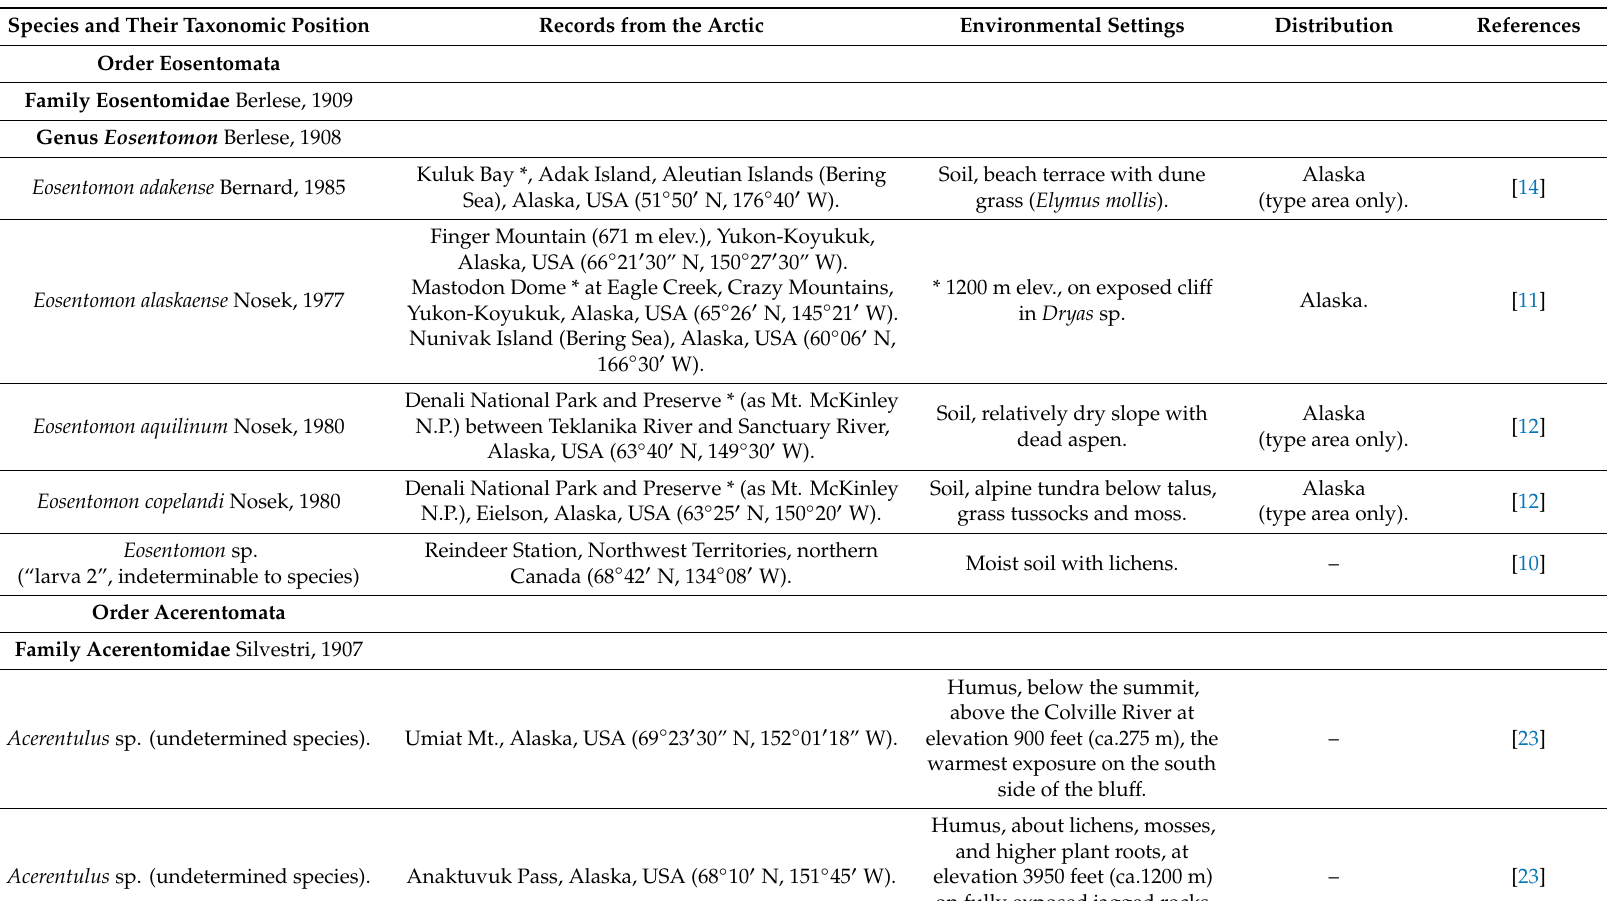
Table 1. A list of all records of Protura from the Arctic regions with information on their taxonomic position, and geographical and environmental distribution. – * type